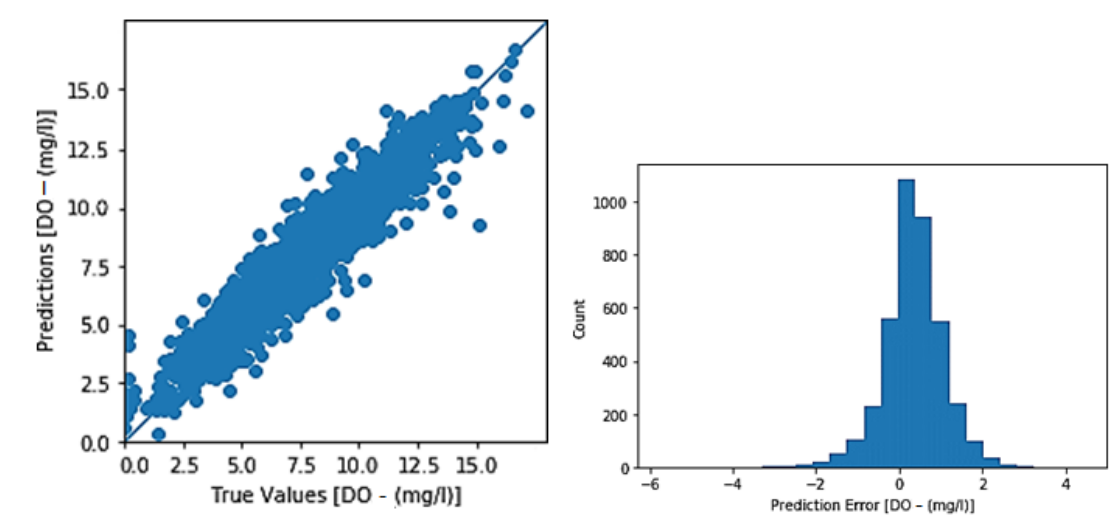
Figure 11. True vs. predicted values (left); predicted error (right) (Toichio station, structure 7-32-32-1).